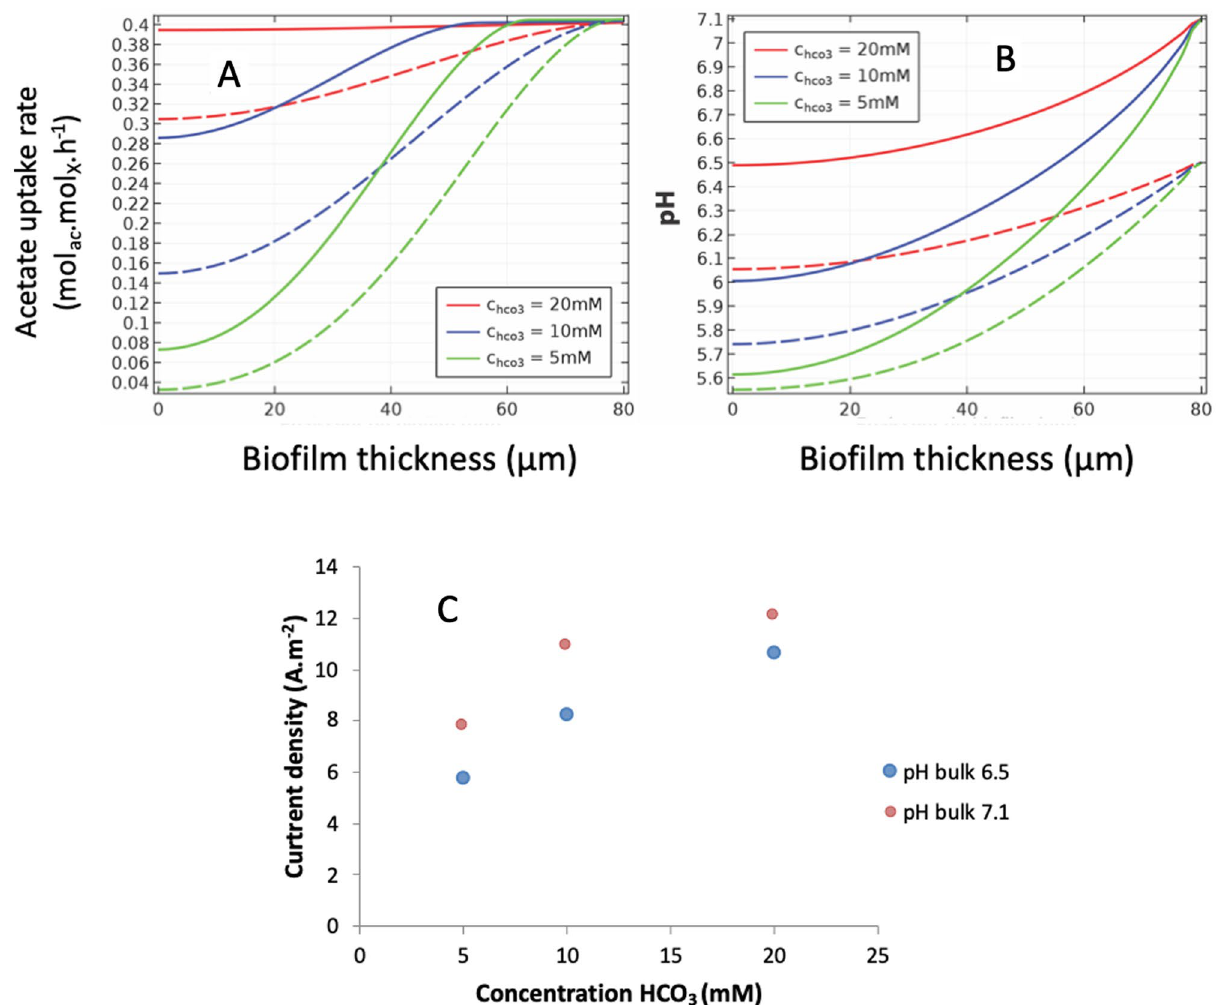
Figure 4. Simulation of the influence of pH on biofilm performance as a function of its thickness for acetate uptake ( A ) and pH ( B ), and total carbonate concentration for current density ( C ). Solid lines: pH bulk 6.5; Dashed lines: pH